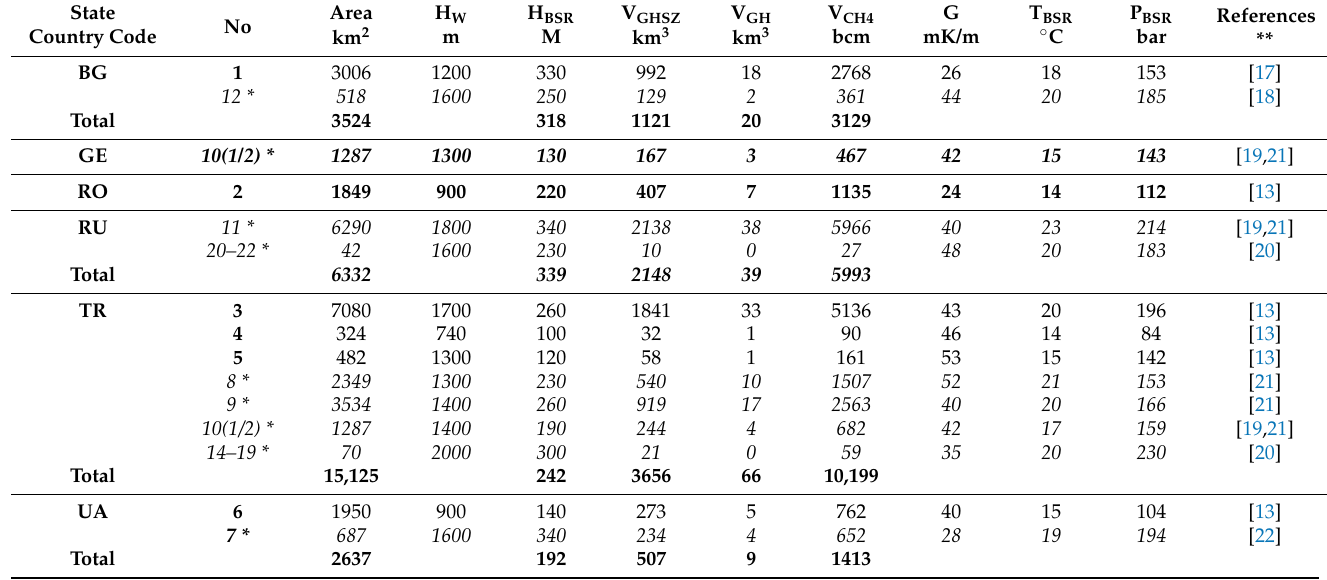
Table 1. Black Sea GHDs (BSR areas) ordered by EEZs. H W —average water depth; H BSR —average thickness of the GHSZ (sediment volume between the seafloor and the BSR) determined from Figures 2 and 3; V GHSZ —sediment volume between the seafloor and the BSR; V GH —volume of GHs;